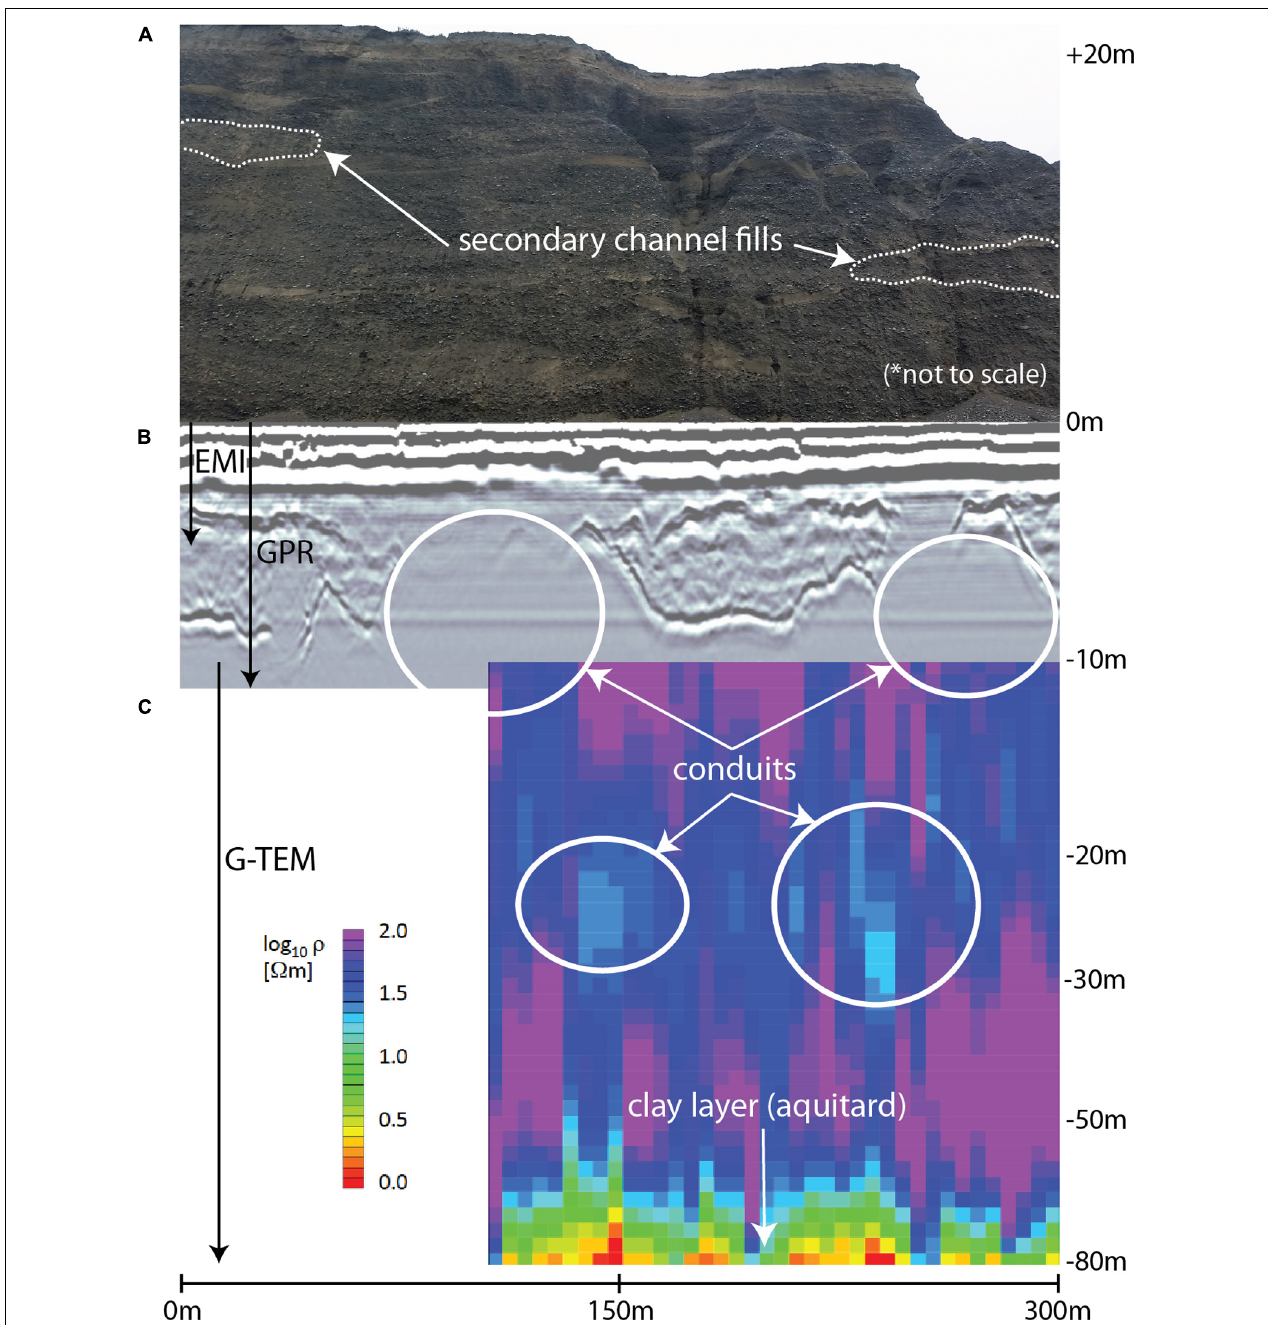
FIGURE 10 | Composite depth slice from the top of the coastal bluff to the maximum depth of investigation probed by the G-TEM system. Secondary channel fills outlined in (A) , extending into the subsurface, correspond to conductive zones that are outlined in the GPR section (B) and the inverted G-TEM section (C) . Conductive zones illuminate the probable location of groundwater conduits and show evidence for a multilayered